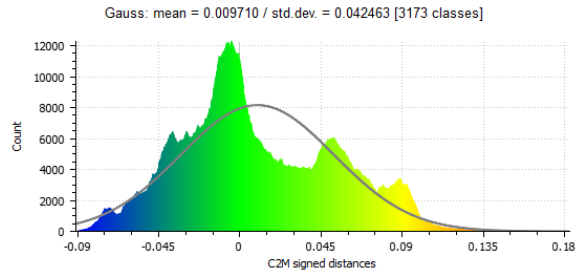
Figure 17. Cloud-to-mesh distances analyses between the sphere interpolated in 2010 and the point cloud obtained in 2017 performed with the open-source software CloudCompare. Mean Std. dev. Table 4. Mean and standard deviation of the cloud-to-mesh comparison.